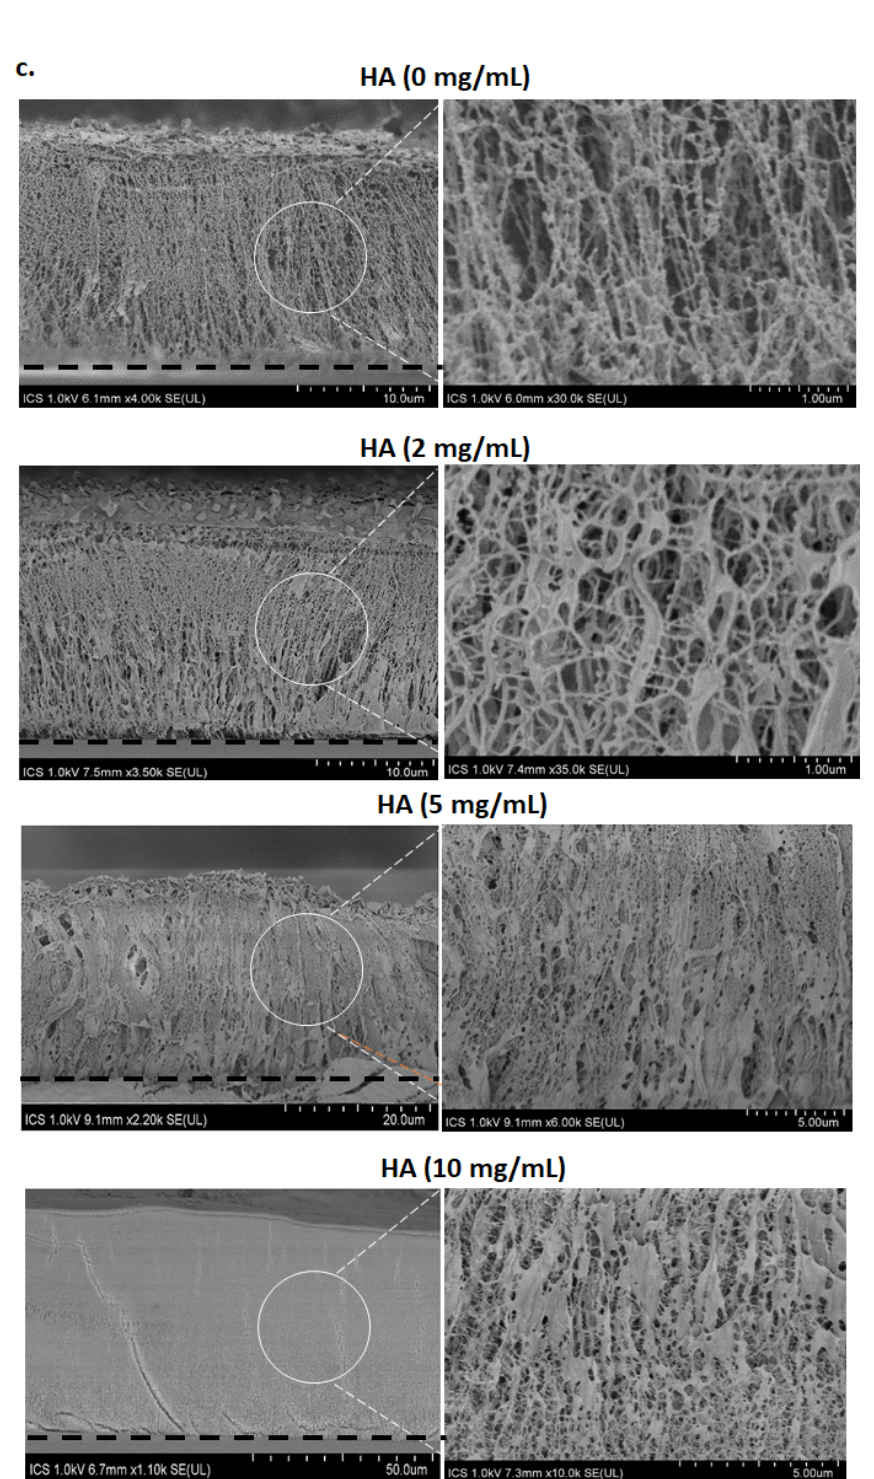
Figure 4. ( a ) Sectional cryo-SEM image of supramolecular hydrogel (dark grey part) formed from silica wafer (light grey part) from Fmoc-FFY self-assembled from PEI/(PSS/PAH) 2 /AP multilayer; ( b ) Hydrogel thickness evolution according to the HA concentration present initially in solution with the precursor peptide Fmoc-FF p Y and AP; ( c ) Cryo-SEM images of hydrogels formed from AP-modified multilayer film in presence of various HA concentrations: 0, 2, 5 and 10 mg/mL. Dashed black lines indicate the separation between the glass substrate and the hydrogel.